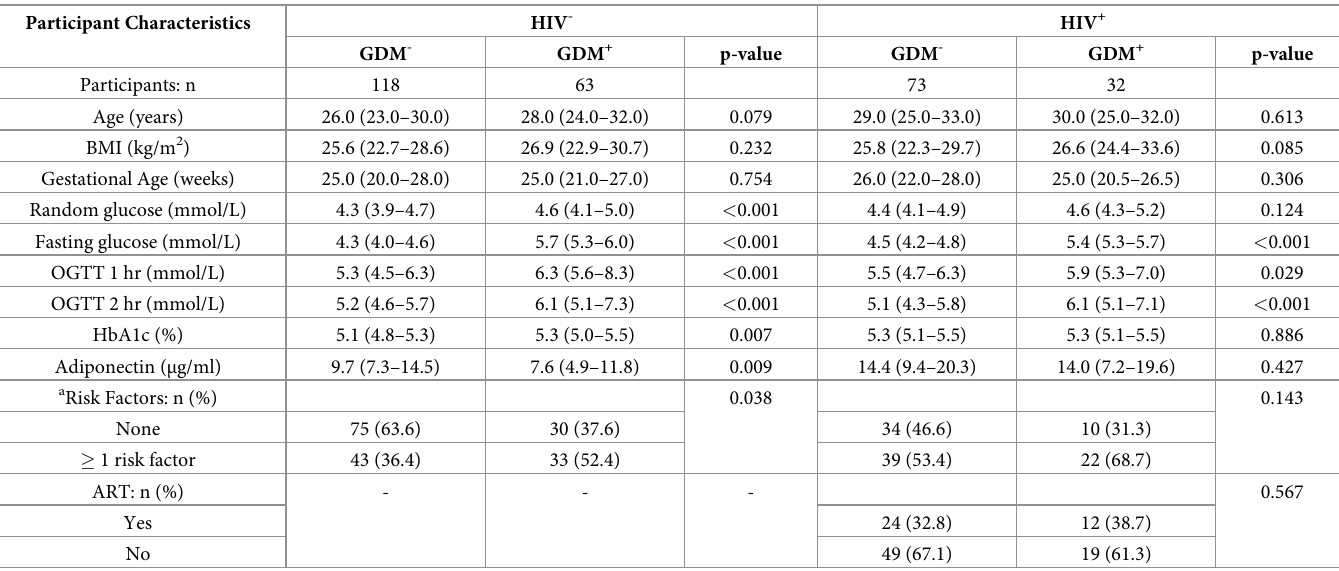
Table 1. Participant characteristics.